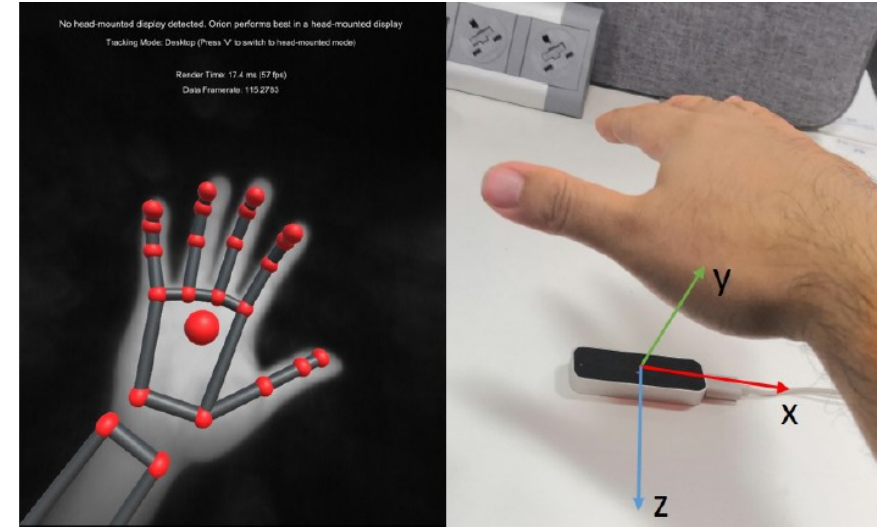
Figure 3. Leap Motion sensor with its Cartesian coordinate system and its visualizer function.